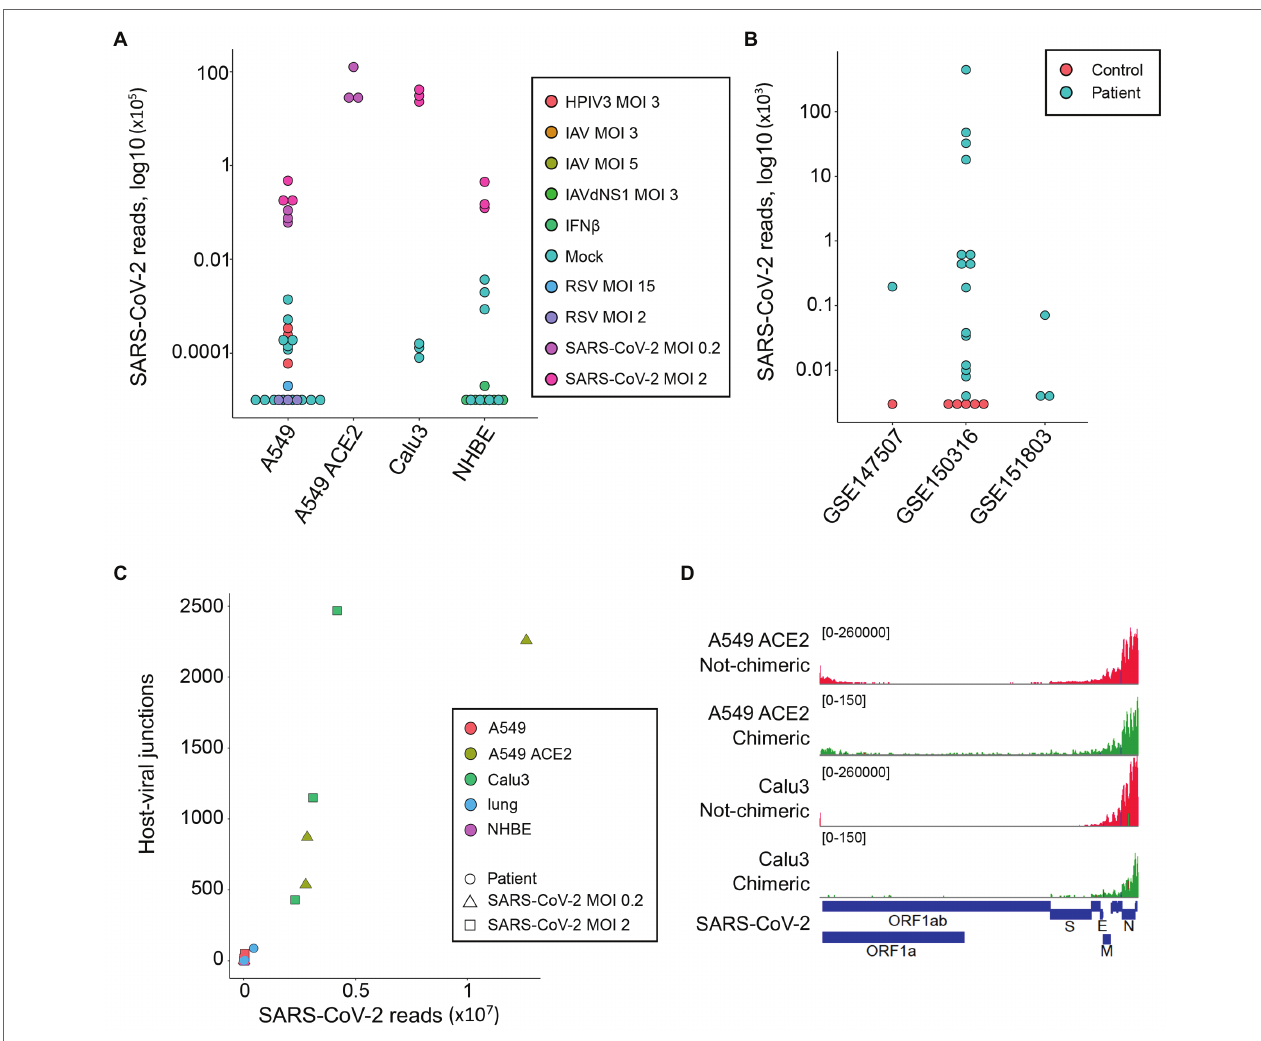
FIGURE 1 | Detection of human-severe acute respiratory syndrome coronavirus 2 (SARS-CoV-2) chimeric reads in RNA-sequencing (RNA-seq) data. (A) Number of non-chimeric reads uniquely aligning to SARS-CoV-2 genome in RNA-seq data (GSE147507) from parental A549 cells, A549 cells overexpressing ACE2 (A549 ACE2), Calu3 cells, and normal human bronchial epithelial (NHBE) cells. The cells were infected or not (Mock) with human parainfluenza virus type 3 (HPIV3), influenza A virus (IAV), IAV lacking the antiviral NS1 gene (IAVdNS1), respiratory syncytial virus (RSV), or SARS-CoV-2, at different multiplicities of infection (MOIs), or treated with recombinant IFN β (IFN β ). (B) Number of non-chimeric reads uniquely aligning to SARS-CoV-2 genome in RNA-seq data from coronavirus disease 2019 (COVID-19) patient lung samples and healthy uninfected control lung samples, from the indicated studies. (C) Number of human-SARS-CoV-2 junctions plotted against non-chimeric SARS-CoV-2-mapping reads in the same samples. (D) Alignment of human-SARS-CoV-2 chimeric and non-chimeric RNA-seq reads from SARS-CoV-2 infected A549 ACE2 and Calu3 cells across the SARS-CoV-2 genome, visualized on integrative genomics viewer